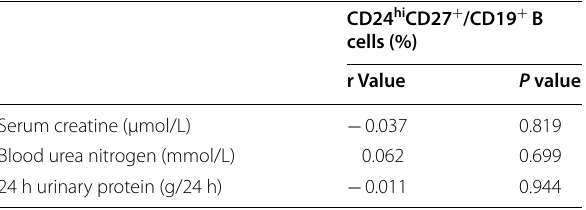
Table 2 Correlation between the proportion of nitrogen (BUN), and 24 h urinary